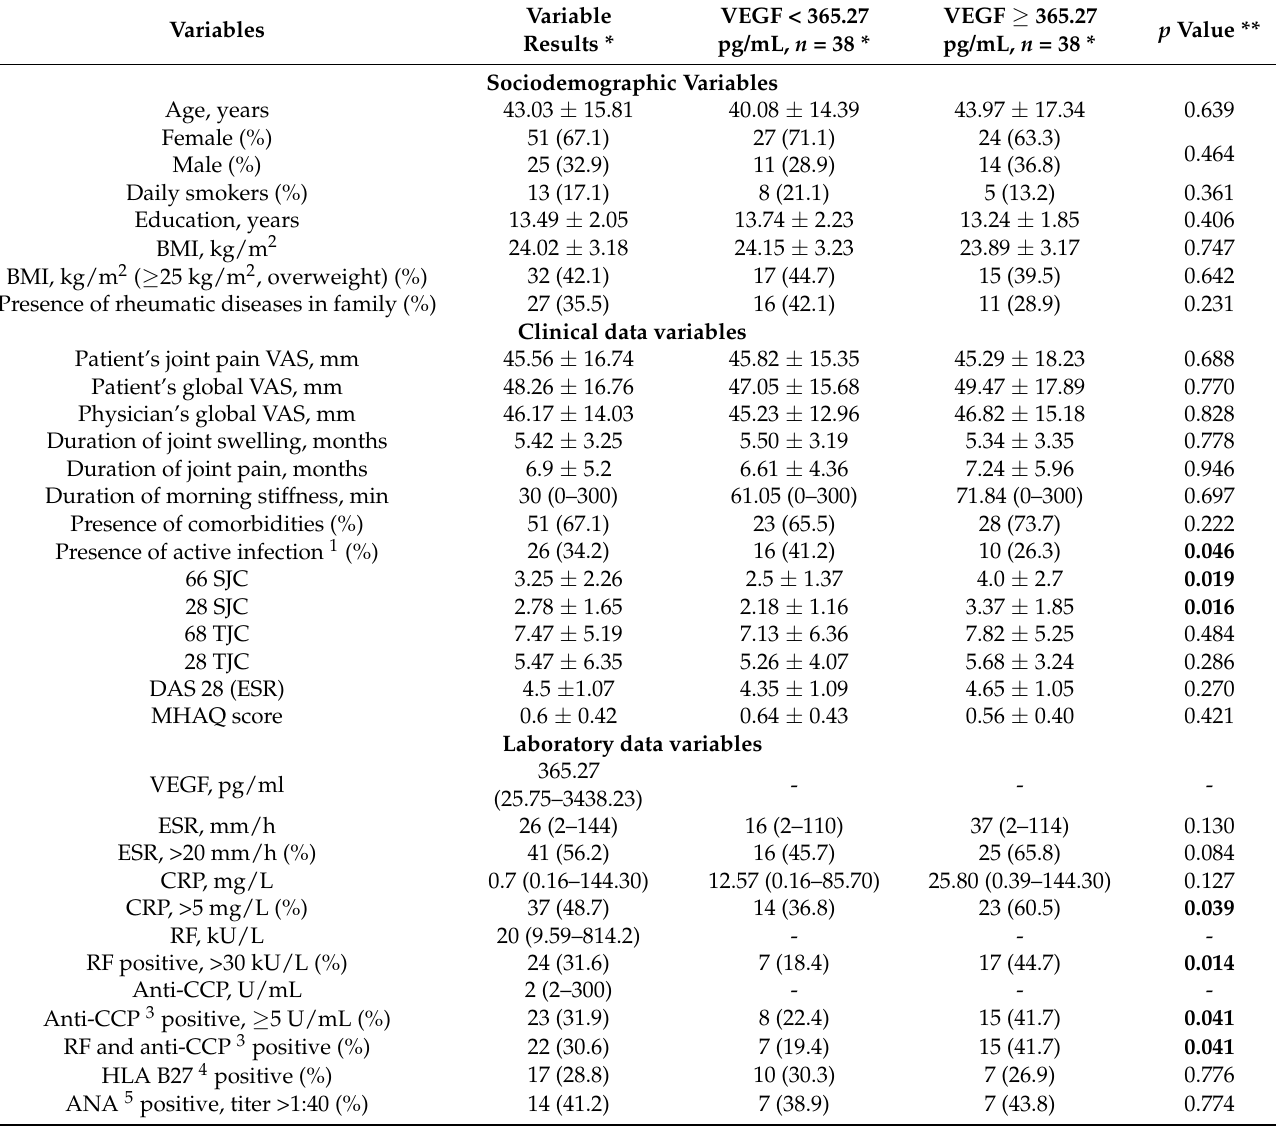
Table 3. Sociodemographic, clinical, laboratory and ultrasound parameters and their distribution based on VEGF median levels in the undifferentiated arthritis patient